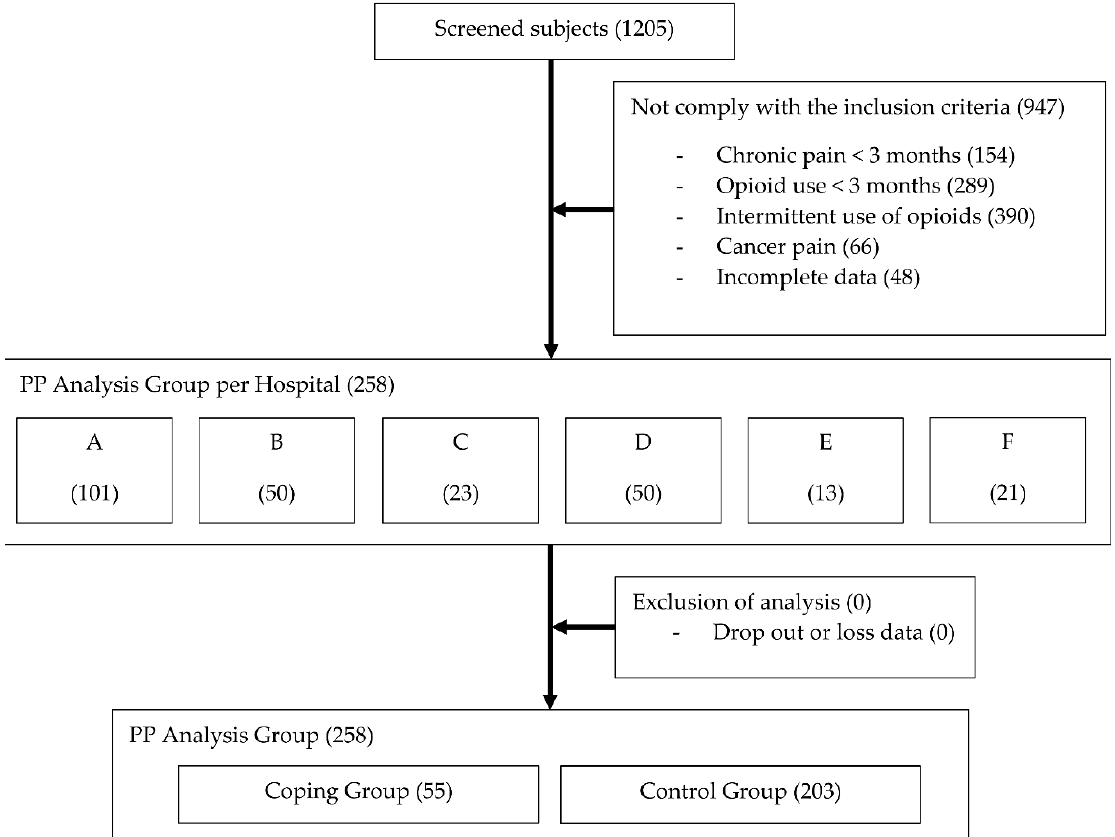
Figure 1. Flow diagram of participants. A, B, C, etc., indicate the hospitals that participated in the study. PP, per-protocol.